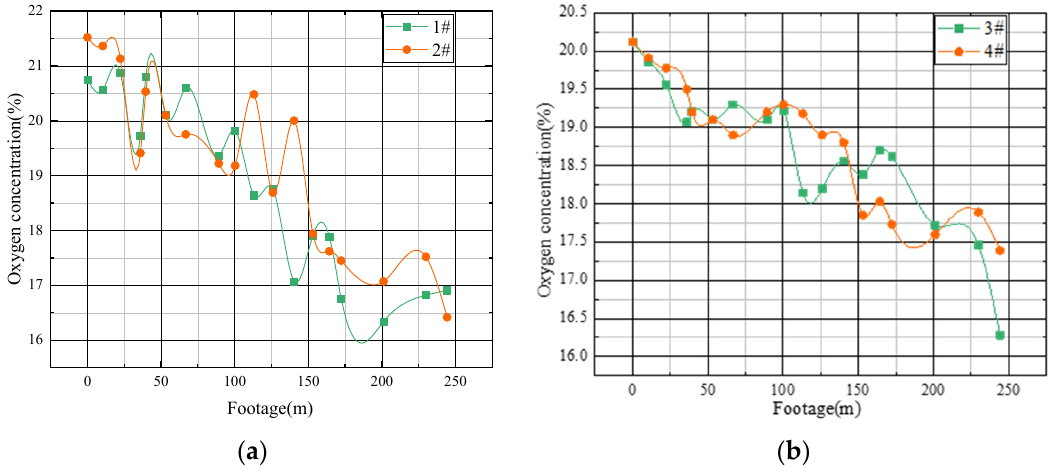
Figure 5. Oxygen concentration distribution at each measuring point (own elaboration).